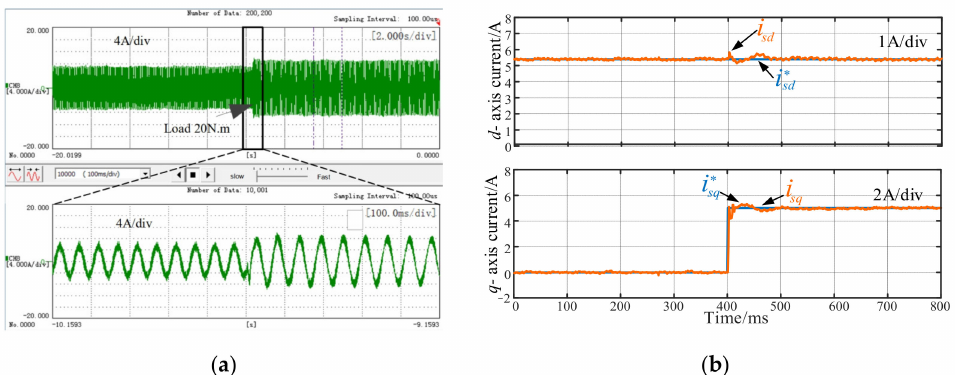
Figure 29. Improved complex vector controller experimental waveforms: ( a ) A-phase stator current; ( b ) dq -axis current